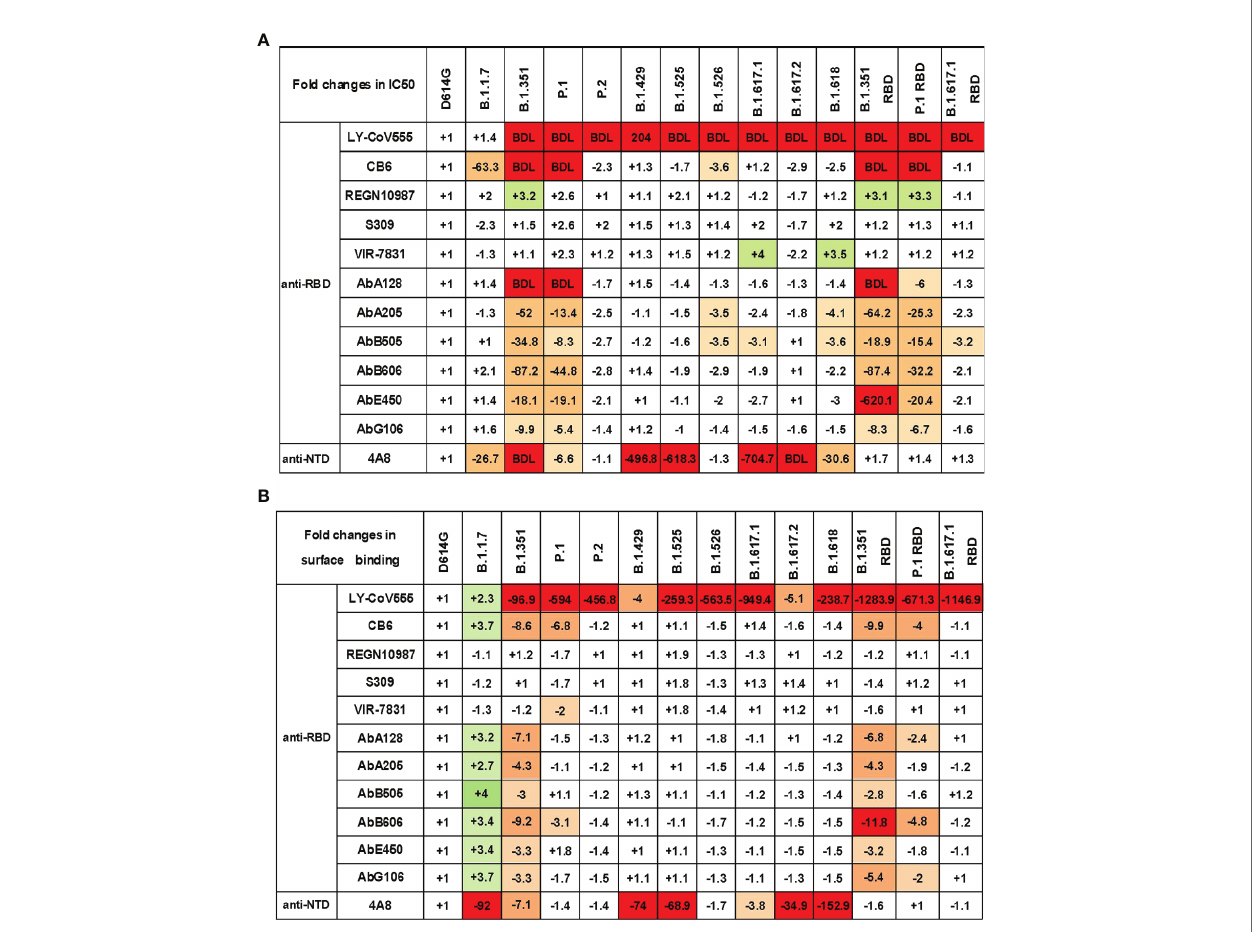
FIGURE 4 | SARS-CoV-2 variant S pseudoviruses reduce neutralization and binding of mAbs. (A) The fold changes in neutralizing activity (IC50) of the mAbs against SARS-CoV-2 variants pseudovirus relative to D614G. (B) The fold changes in binding activity [mean fl uorescence intensity (MFI)] of the mAbs against SARS-CoV-2 variants pseudovirus relative to D614G. “ − ” represents the decrease of sensitivity to the antibody, and “ + ” represents the increase of sensitivity to the antibody. The values marked in red indicate that sensitivity decreased at least 3-fold for IC50 or 2-fold for MFI, while those in green indicate that sensitivity increased at least 3-fold for IC50 or 2-fold for MFI. BDL indicates neutralizing activity below the detection limit. Experiments were done